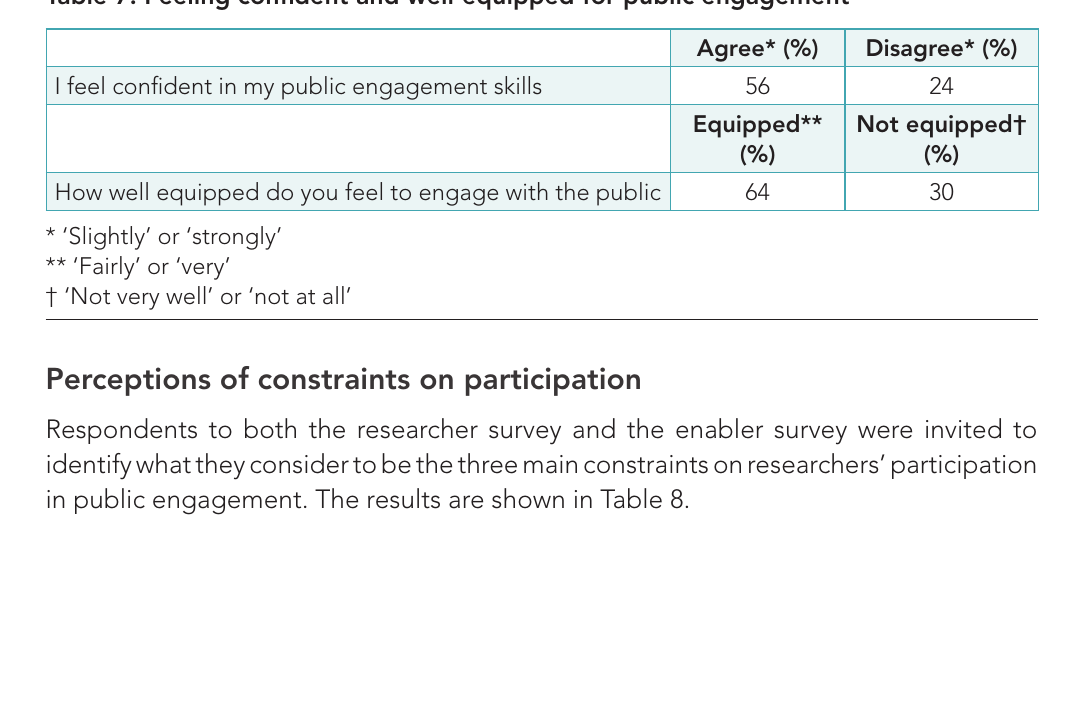
Table 7: Feeling confident and well-equipped for public engagement